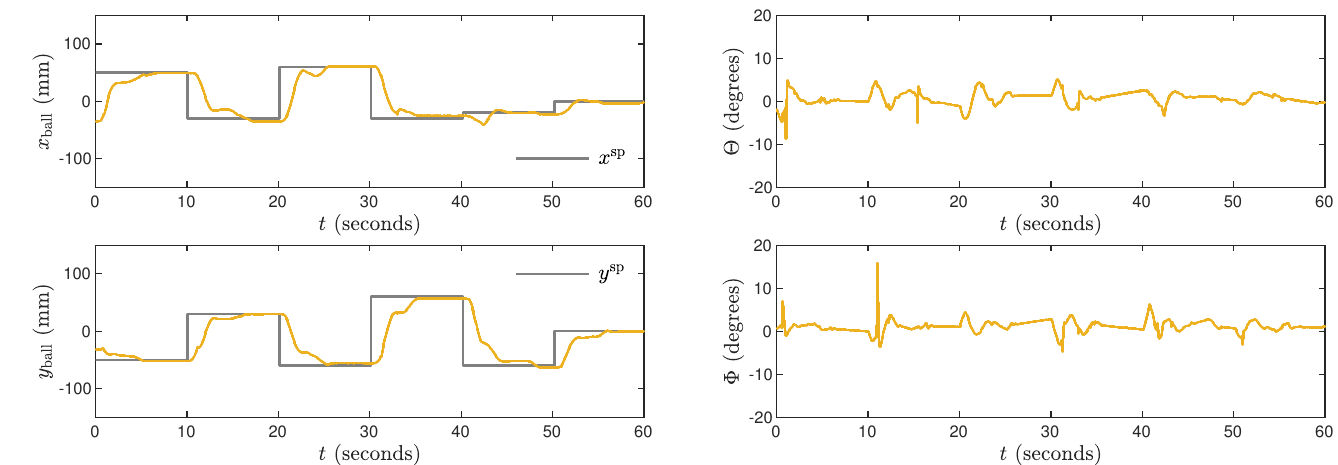
Figure 12. Experimental results of the LQR3